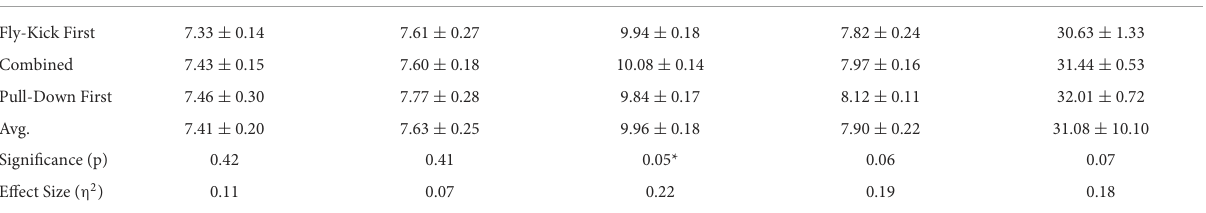
TABLE 3 Female start and turn performances for each of the underwater pullout techniques across the 50, 100, and 200m breaststroke race events. Technique